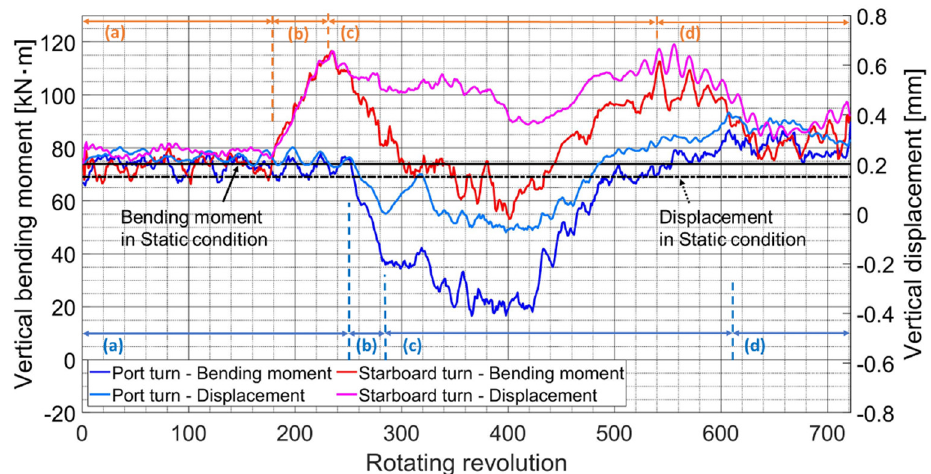
Figure 18. Comparison of behaviors between the port turn and the starboard turn under the fully laden condition. Stage (a): Rudder angle 0-degree: NCR straight going (begin). Stage (b): Rudder angle changes from 0 to 12-degree (port, starboard). Stage (c): Rudder angle 12-degree: ship’s heading is gradually changing. Stage (d): Rudder angle 0-degree: NCR straight going (end). Through this, it can clearly be seen that the shaft behavior compared with going straight ahead shows a high degree of consistency in both the direction of the bending